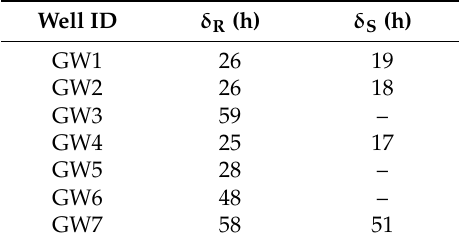
Table 6. Rainfall δ R and sea level δ S lags found for each